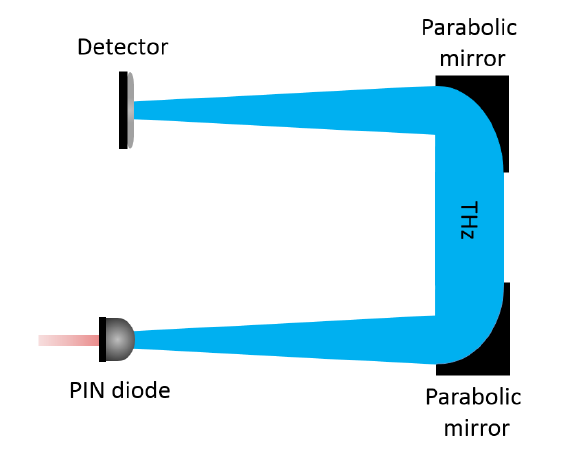
Figure 3. Experimental setup for the measurements. For THz power measurement, the detector was a pyroelectric device, calibrated by the PTB. For the THz current measurements, it was replaced by the